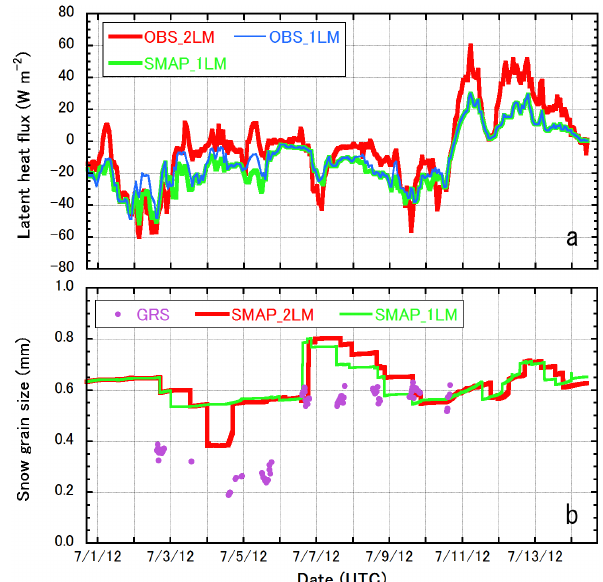
Figure 12. (a) Temporal evolution of 1h averaged latent heat fluxes calculated from atmospheric measurements at 6 and 3m above the surface (OBS_2LM) and measurements at 3m above the surface (OBS_1LM), as well as the SMAP simulation forced by one-level (3m above the surface) atmospheric measurements (SMAP_1LM). (b) Comparison of surface snow grain size at the SIGMA-A site during the IOP with surface snow grain size from ground-based remote sensing (GRS) using spectral albedo data measured with a spectrometer and those from the SMAP simulations driven by two-level (6 and 3m above the surface) atmospheric measurements (SMAP_2LM) or one-level (3m above the surface) atmospheric measurements